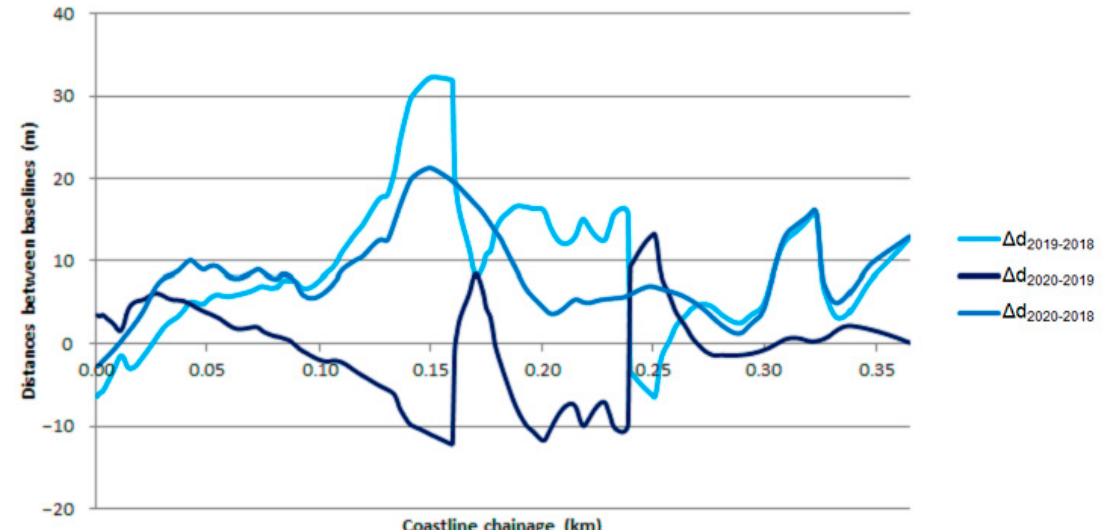
Figure 8. Distances between TSBs of the waterbody adjacent to the public beach in Gdynia measured with the hydrographic method in 2018–2020.